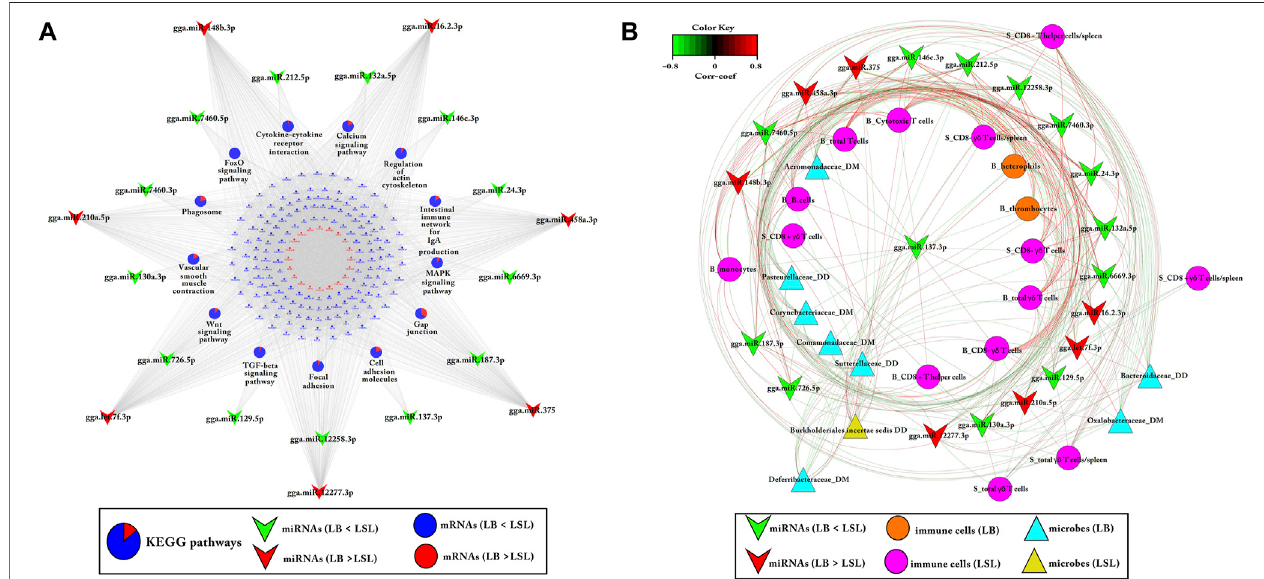
FIGURE 8 | Correlation network analysis of selected features for miRNAs, immune cells, and microbes, and KEGG pathway enrichment analysis of these miRNAs andtheirnegativelycorrelatedDEtargettranscripts. (A) KEGGpathwayenrichmentanalysisofbio-signaturemiRNAsandtheirnegativelycorrelatedDEtargetgenes( p ≤ 0.05). The pie charts indicate the proportion of the DE gene ’ s contribution to KEGG pathways. The blue ellipse showed that mRNAs were downregulated in LB and upregulated in LSL, while the red ellipse showed the opposite. The green symbol depicts miRNAs downregulated in LB and upregulated in LSL, whereas the red symbol indicates those upregulated in LB and downregulated in LSL. (B) Correlation network derived from Pearson correlations calculated between bio-signatures of miRNAs, immune cells, and microbes (FDR ≤ 5%). Circular shape showed immune cells linked to LB (orange) or LSL (pink). Likewise, the sky blue triangle indicated microbial taxa linked with LB, while the yellow triangle showed microbial taxa associated with LSL. The red and green connections indicated the positive and negative correlation,